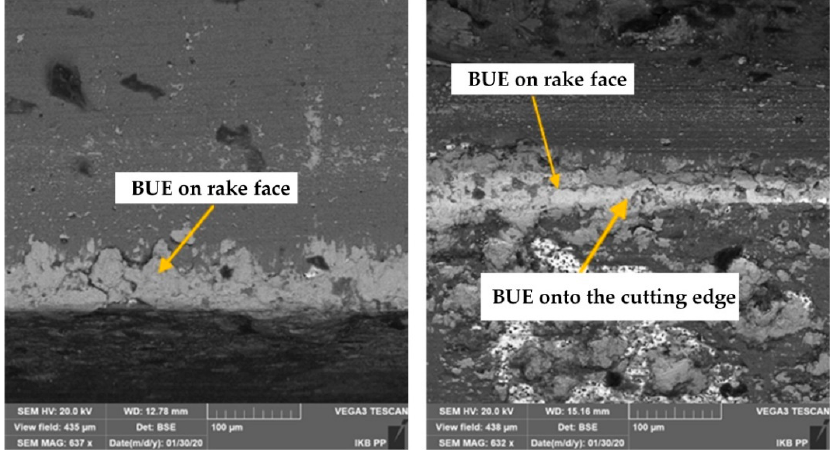
Figure 8. The SEM images of DDCC inserts after grooving with v c = 1200 m/min, f = 0.2 mm/rev, t s ≤ 2 min.